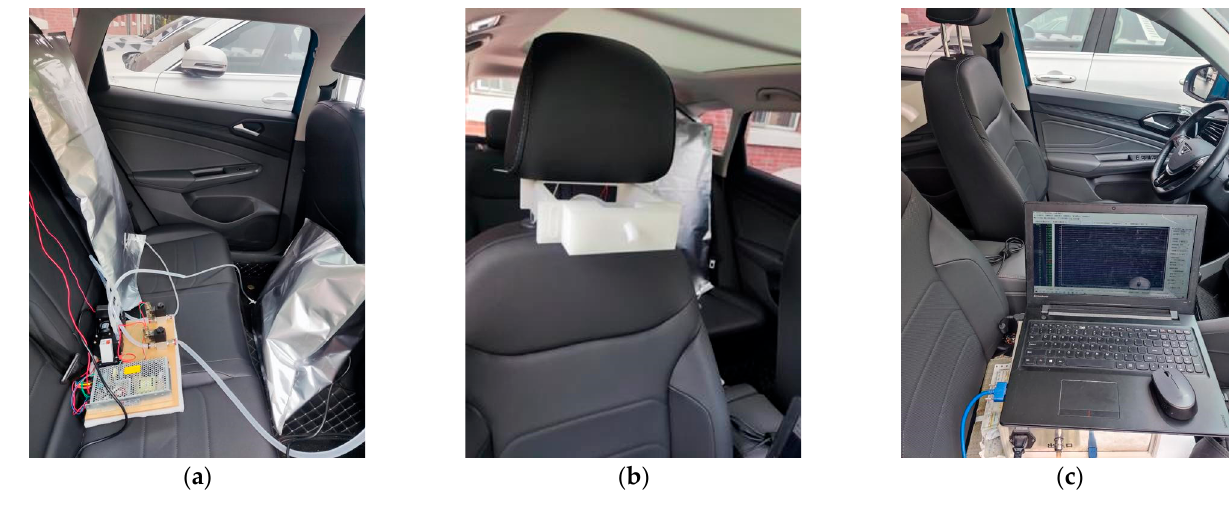
Figure 4. Pictures of the actual test scene. ( a ) A photo of the simulated expiratory device placement; ( b ) A photo of the exhalation port structure placement; ( c ) A photo of the electronic nose and PC placement.